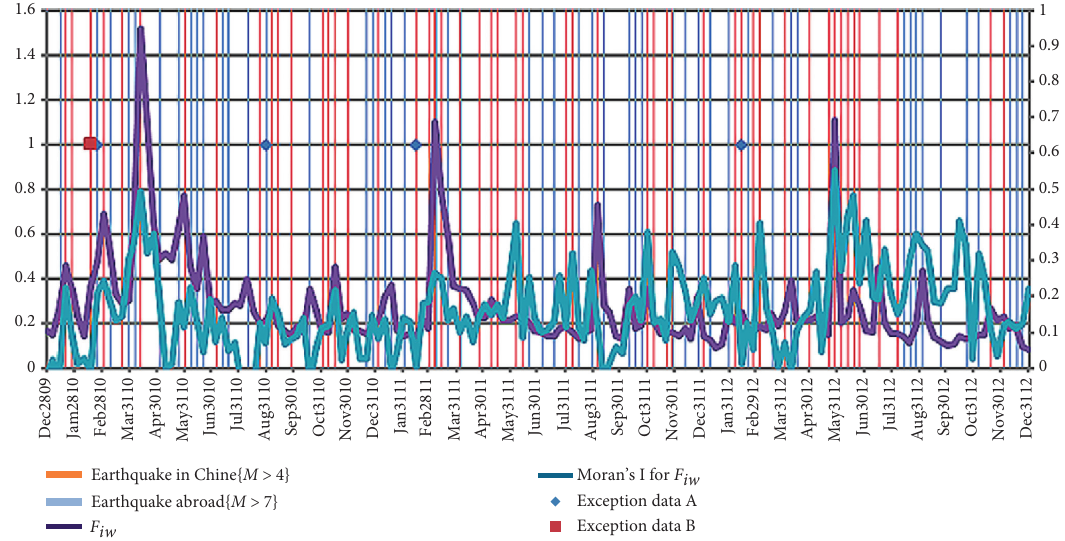
Figure 5: Time series of F